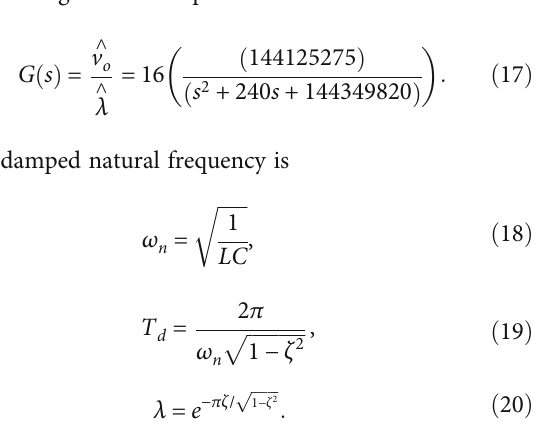
of FKYBC with HPC for o